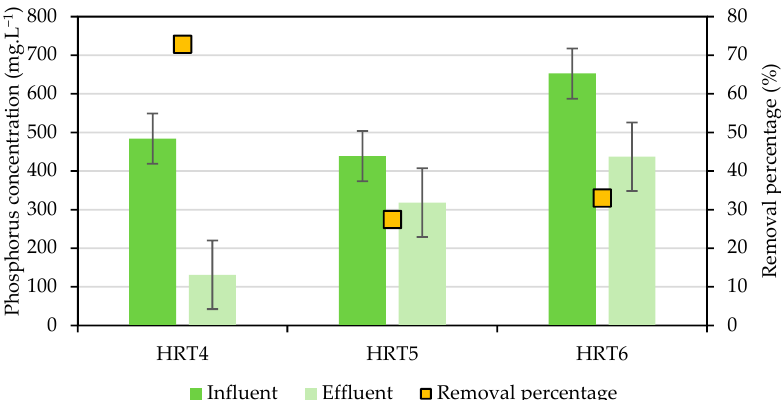
Figure 8. Average concentrations ( n = 3 samples per HRT) of total phosphorus in the influent (tP influent) and effluent (tP effluent) of the bioreactor, and the respective removal rates (error bars: standard deviation) (concentrations: on the left y axis; removal percentages: on the right y axis).